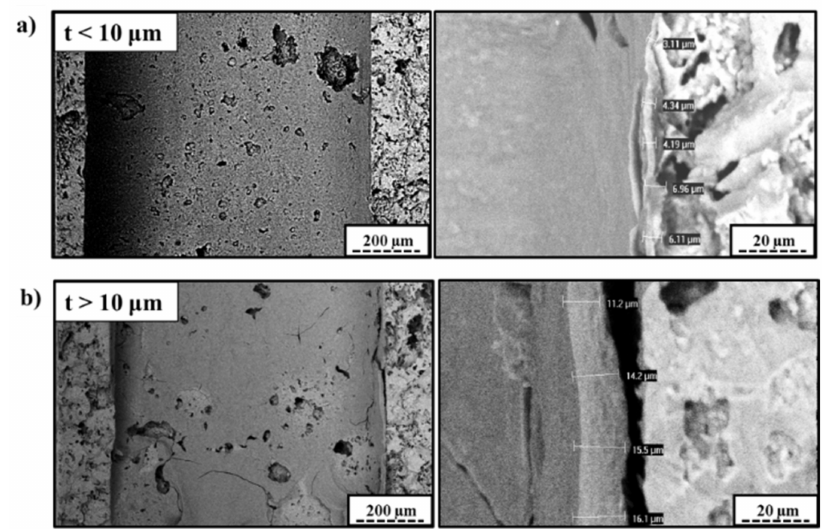
Figure 15. Influence of the coating thickness on the appearance of cracks for sample B after drying step; ( a ) thickness below the critical value, ( b ) thickness above the critical value.